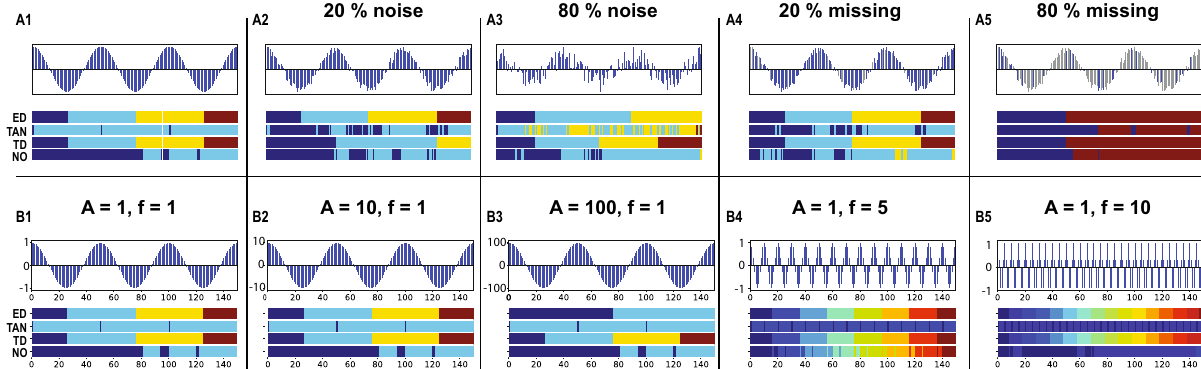
Figure 4. Community structure for different edge weights, amplitudes and frequencies. We compared the path length based algorithm (PL), using a weighted dual perspective visibility graph (WDPVG), for 4 types of edge weights: Euclidean distance (ED), the tangent of the view angle (TAN), the time difference (TD) and no weighting (NO). We simulated sinusoidal signal time series with different noise levels and missing data (20% and 80%), and obtained the communities using the PL algorithm ( A1–5 ). We also changed the amplitudes, A from 1 to 100 (arbitrary units), and the frequencies, f, from 1 to 10, and detected the communities of the WDPVG from the signals ( B1–5 ). The community structure is represented by a color bar, with time points in same community assigned the same color. The edge weights of ED and TD work well among the 4 types edge weights, and the PL algorithm shows robustness under amplitude or frequency